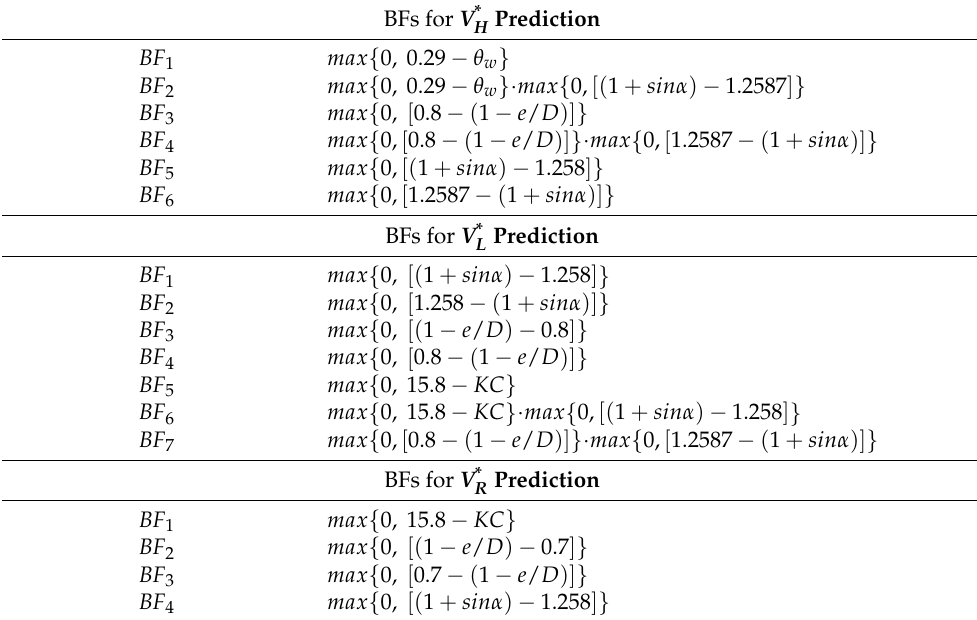
Table A3. Explored basis functions (BFs) in MARS models for 3D-scour rate predictions.